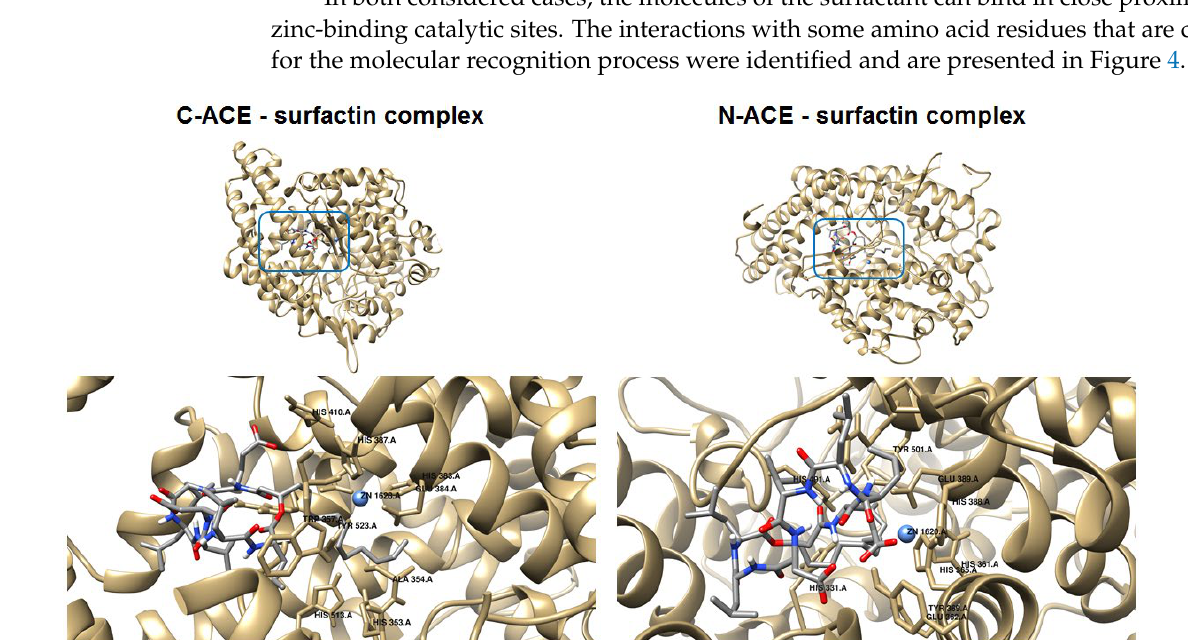
Figure 5. Intermolecular interaction between C - ACE and N - ACE domains with surfactin molecule. The favorable orientation of the ligand to interact with the zinc -binding catalytic site was also obtained in the case of the N- domain of ACE. This particular orientation is